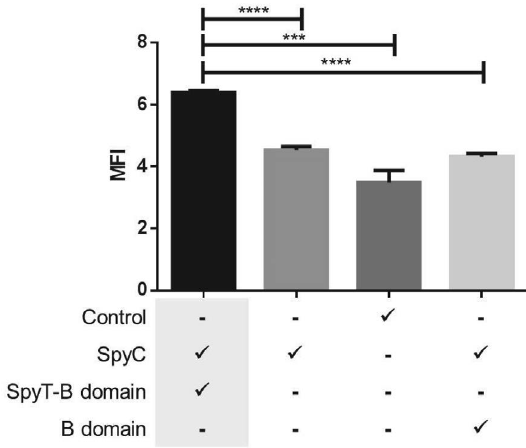
Fig. 5. Flow cytometric analysis of binding of L. lactis -secreted Spy- Tag (SpyT)-B domain to L. lactis cells displaying SpyCatcher (SpyC) on their surface after co-culturing of the two strains. FITC-conju- gated human IgG was used for detection. Mean fluorescence inten- sity (MFI) values were compared to those of controls using Student’s t test. *** p<0.001, **** p<0.0001.